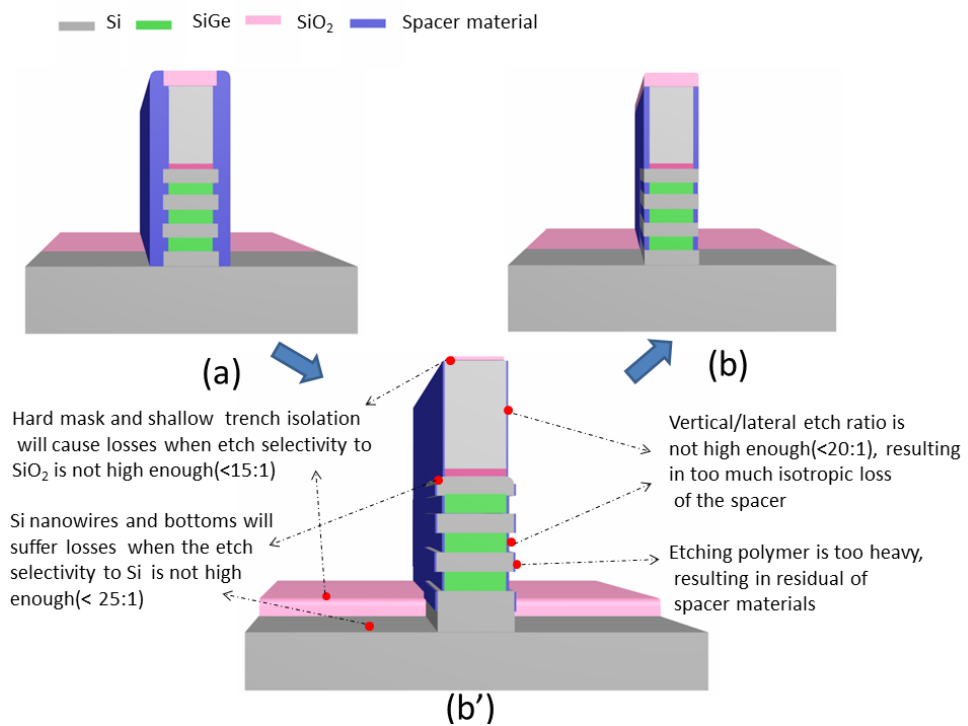
Figure 2. Spacer morphology and inner spacer process challenges: ( a ) conventional spacer; ( b ) inner spacer; ( b’ ) the process challenges need to be overcome from conventional spacer to inner spacer.